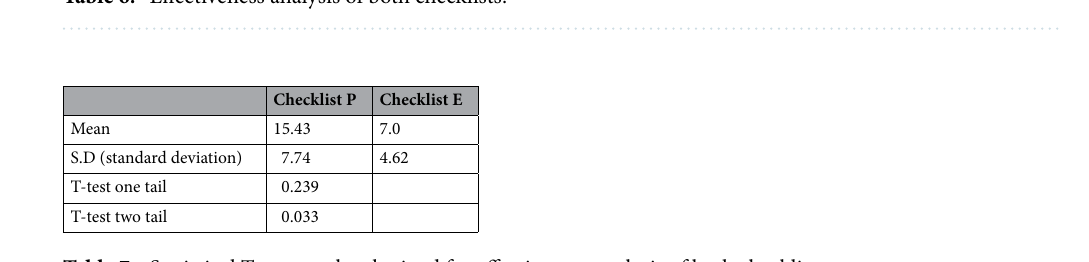
Table 6. Effectiveness analysis of both checklists.